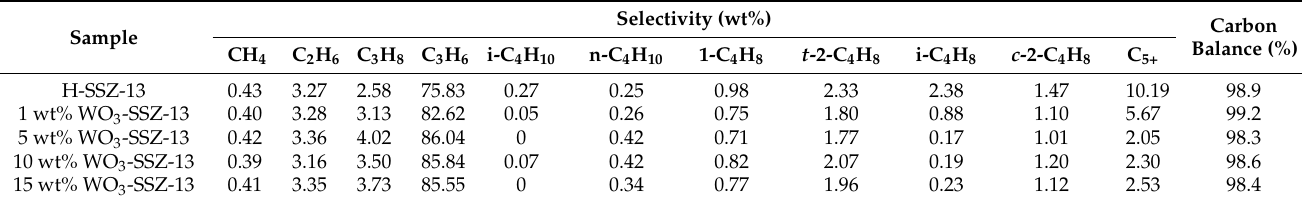
Figure 4. Product selectivity at ca. 65 wt% ethylene conversion for the H-SSZ-13 and WO 3 -SSZ-13 samples. Table 2. Product selectivity and carbon balance at ca. 65 wt% ethylene conversion for the H-SSZ-13 and WO 3 -SSZ-13